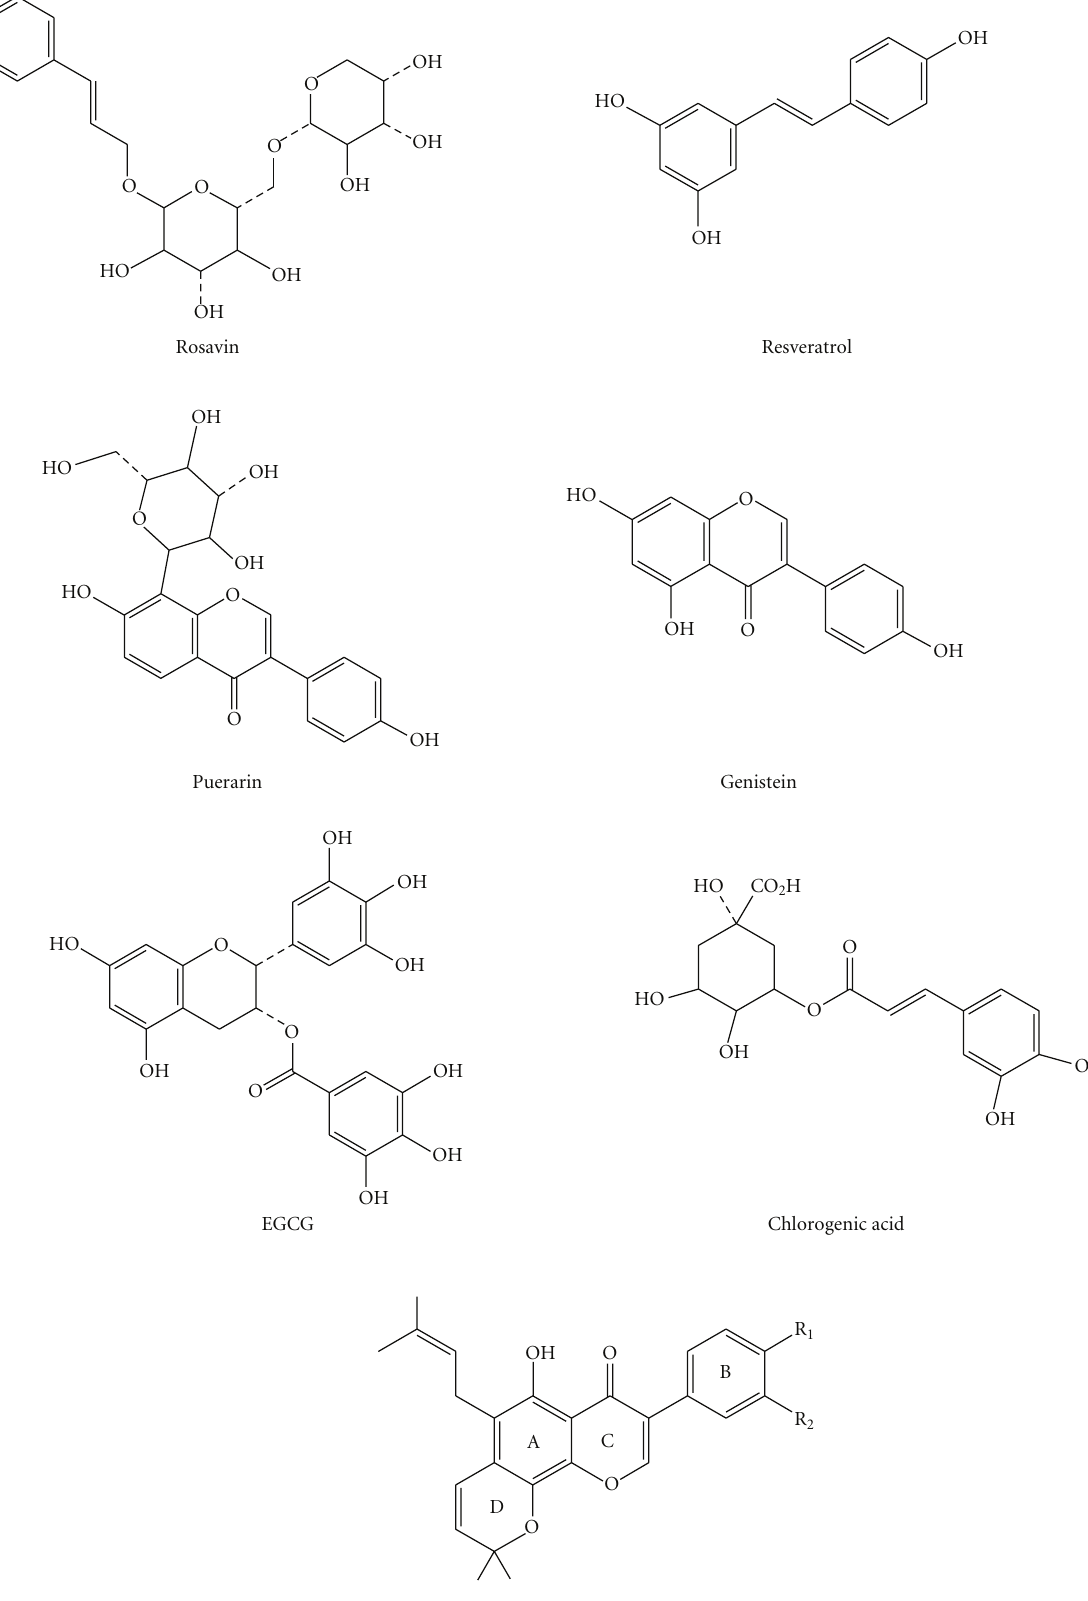
Figure 1: Chemical structure of antioxidant ingredients